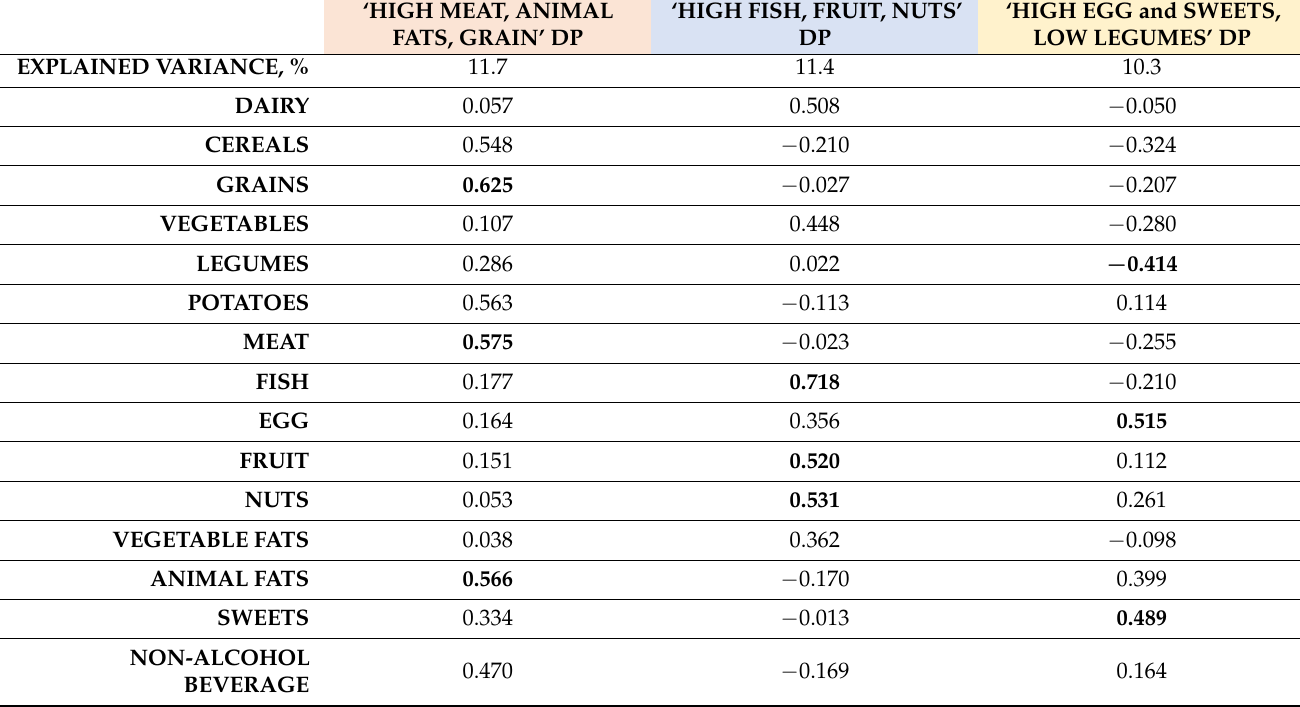
Figure 2. Energy and nutrients intakes referred to Italian LARN recommendations. Energy and nutrient intakes of the study population compared to the Italian LARN references. The average intake was calculated as bromatological data resulting from the analysis of the daily diaries weighed over 7 days (7-DR diaries). Table 3. Dietary patterns extraction from FFQ analysis: relation between food groups and dietary patterns expressed by factor